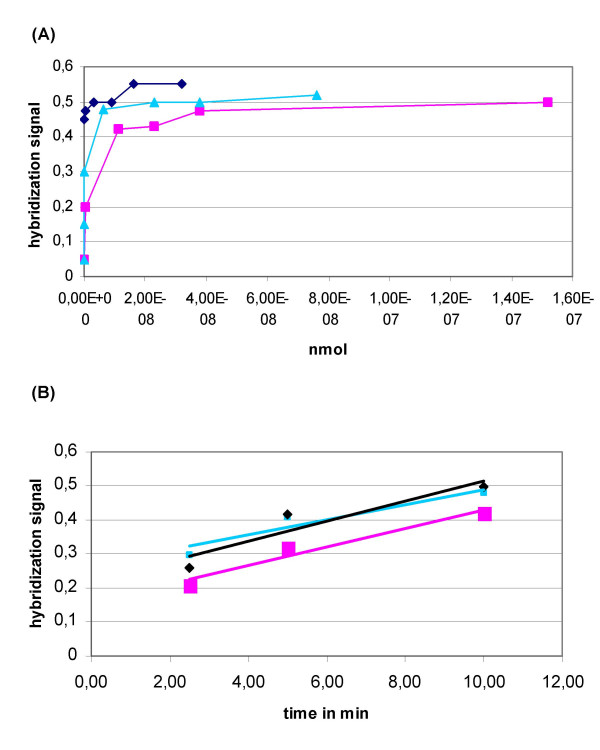
Hybridization signal intensity on the array obtained with different amounts of synthetic polyA-RNA spiked in. Synthetic polyA-RNA species were generated using sequences of bacteriophage λ. An oligo (A)30 sequence at each 3'end was incorporated in the course of a PCR reaction. Templates for in vitro transcription with T7 RNA polymerase were engineered by cloning in a vector containing a T7 promotor and digesting with HIND III. The transcripts were purified with Oligotex mRNA Minikit (Qiagen, Hilden, Germany) to get pure polyA-transcripts. A) Different amounts of three synthetic polyA-transcripts (B: light blue; H: margenta; J: black) were spiked in as exogenous controls for labelling, hybridization and detection. The hybridization signals determined after 10 min incubation with the HRP substrate are presented versus the amounts of controls spiked in. B) Data analysis at 2.5, 5 and 10 min, respectively, after incubation with the HRP substrate, shown for three different synthetic RNA concentrations (black: 3.2E-9 nmol of sequence J, light blue: 6.48E-9 nmol of sequence B, margenta: 1.14E-8 nmol of sequence H). This way, the dynamic range of array analysis can be expanded to some extent.